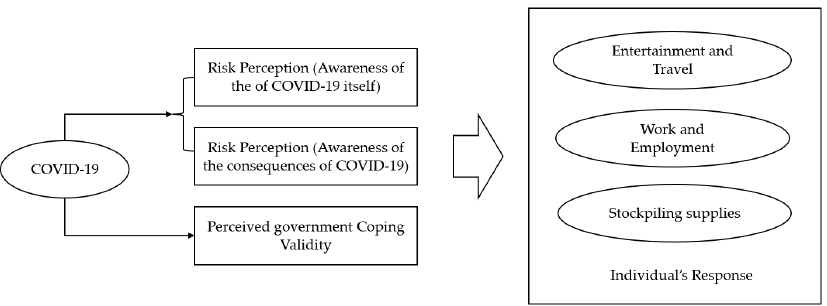
Figure 1. The conceptualized framework of risk perception, perceived government coping validity, and individual response.